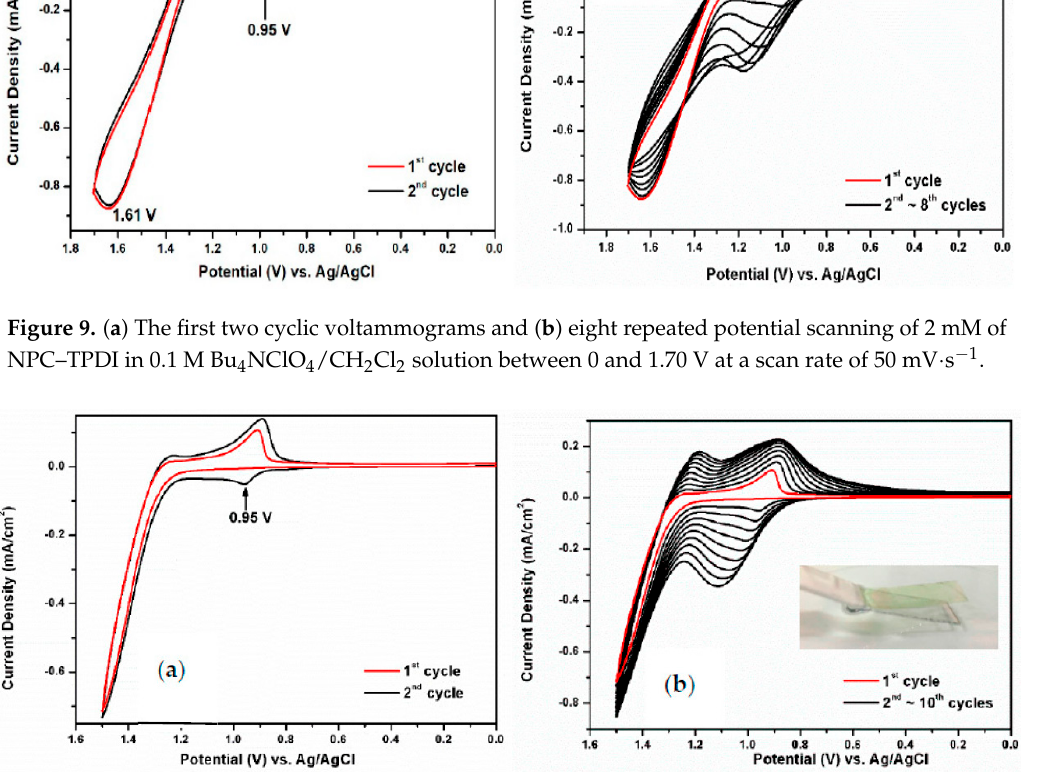
Figure 10. ( a ) The first two cyclic voltammograms and ( b ) ten repeated potential scanning of 2 mM of NPC–TPDI in 0.1 M Bu 4 NClO 4 /CH 2 Cl 2 solution between 0 and 1.50 V at a scan rate of 50 mV s − 1 .